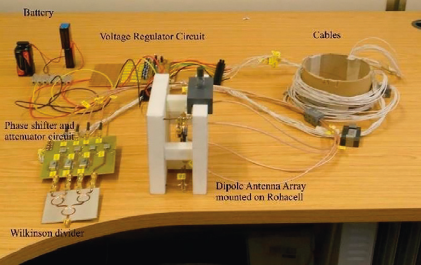
Figure 15: An assembly of a dipole antenna array and an RF beamformer